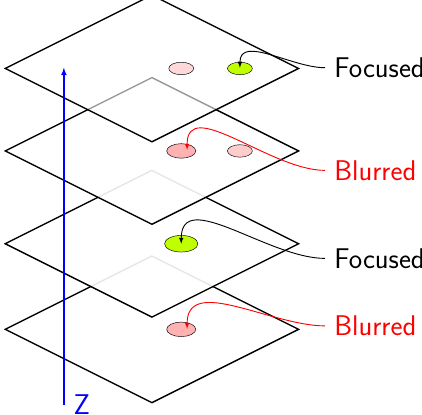
Figure 7. Identifiable grains in the different focal planes to be analyzed.